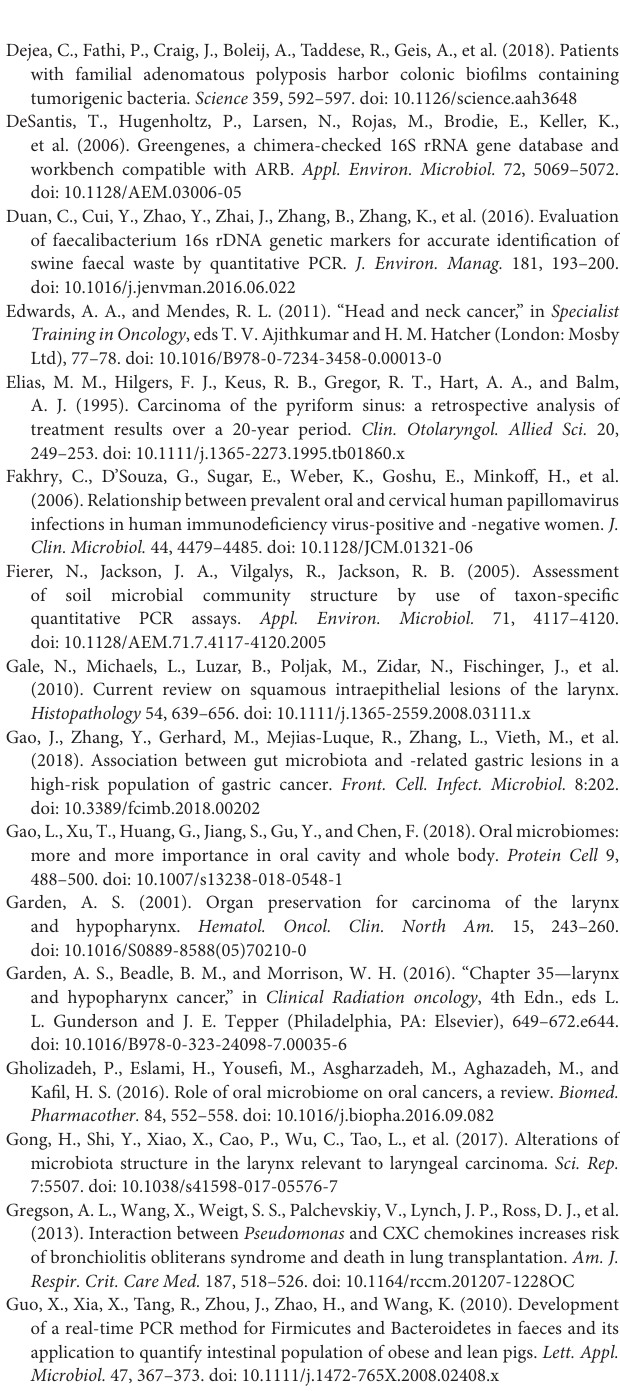
Table S1 | Sample information in the study. Table S2 | Unique OTUs in throat cancer group, vocal cord polyp group, and normal control group. normal control